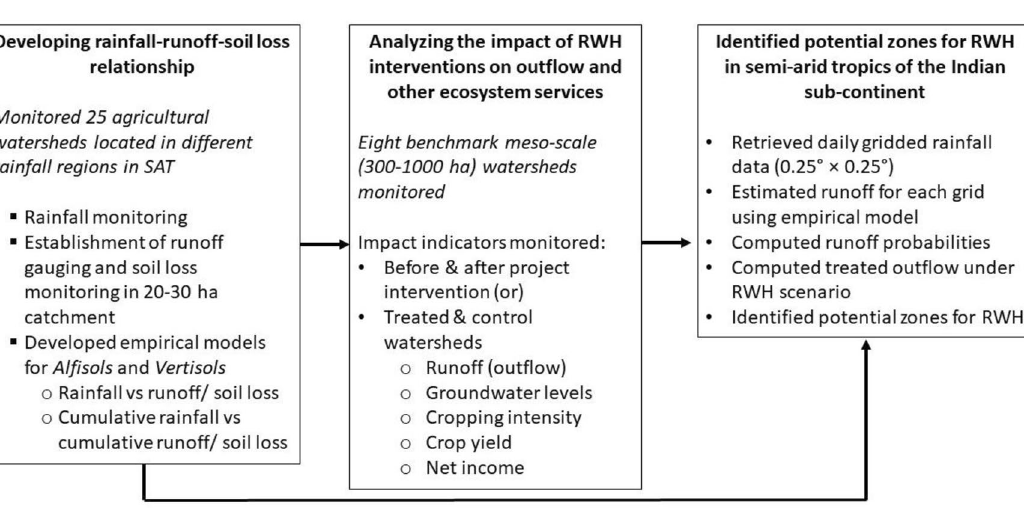
Figure 3. Description of the methodology and data